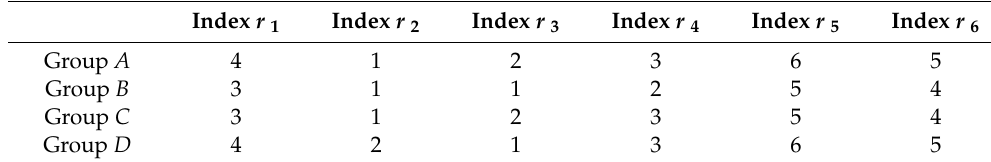
Table 2. Expert ranking results.